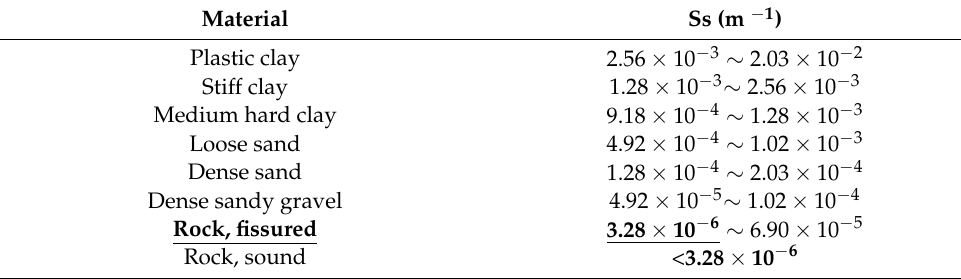
Table 1. Specific storage for different materials [51].